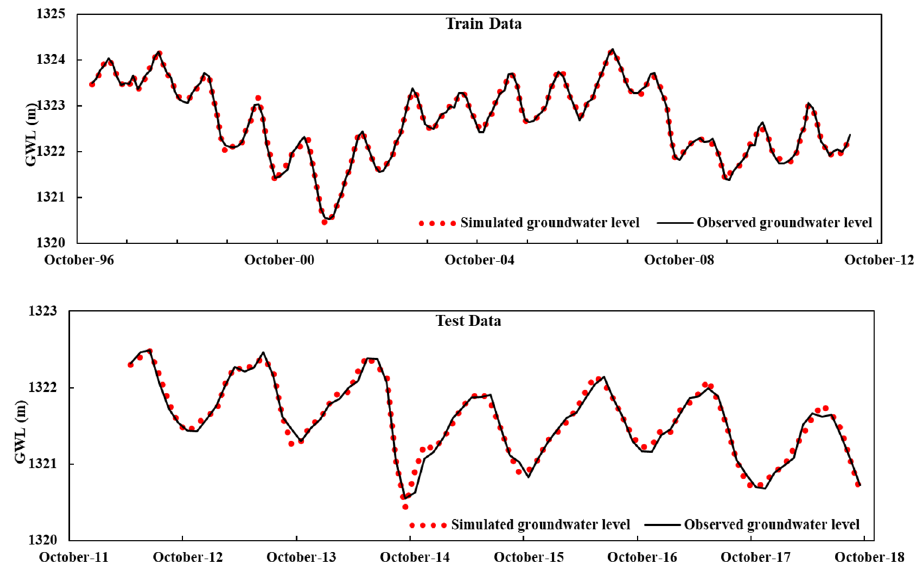
Figure 9. Wavelet-ANFIS/Sym4-simulated and observed GWL-time series for the training (upper panel) and testing (lower panel) phases.